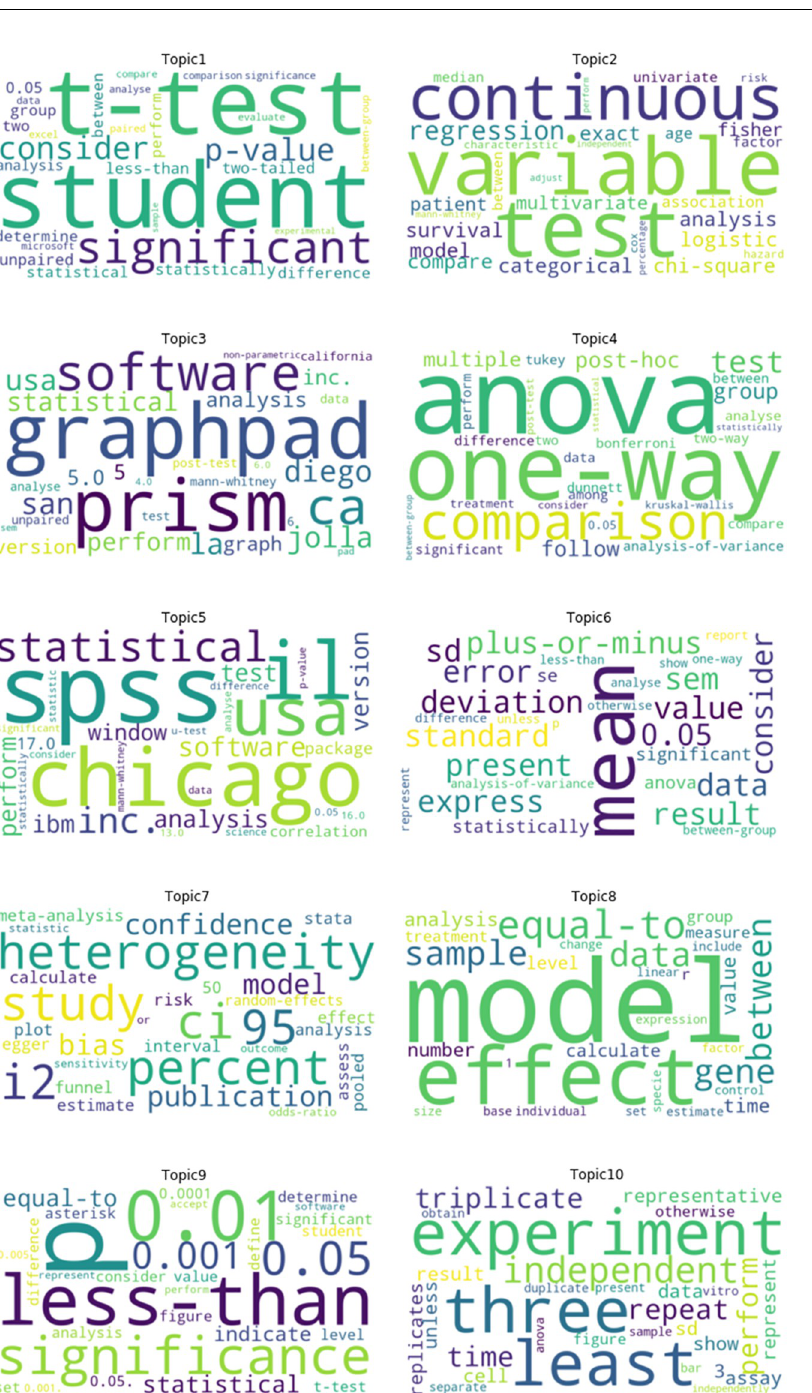
Fig 1. Word clouds for ten topics for statistical methods sections published in PLOS ONE. Evaluation of boilerplate text revealed sections from 484 studies (5.1%) were close matches and 251 (2.6%) were an exact cut-and-paste from another study (Table 3). At the sentence level, the proportion of studies with shared text varied by topic, from 12% in topic 5 (pilot studies) to 38% in topic 3 (student’s t-test) (S4 Fig).